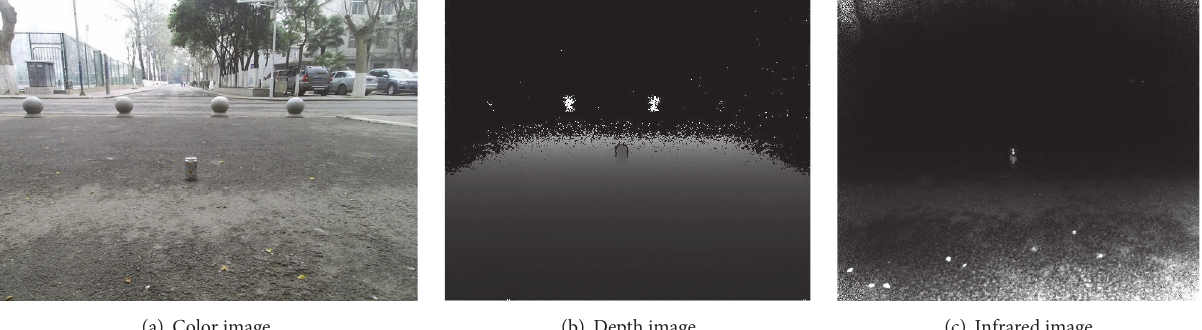
Figure 1: The road scene.